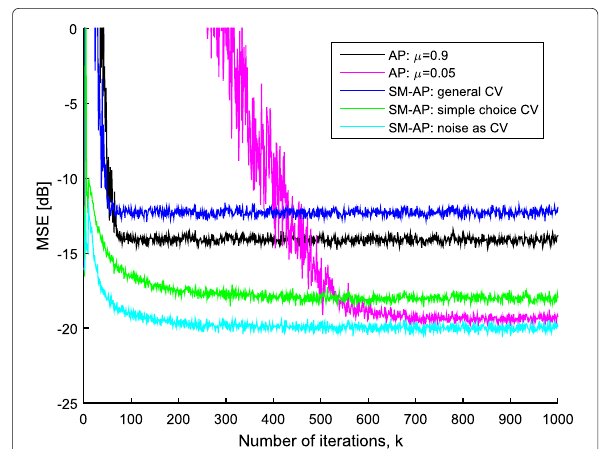
Fig. 8 Learning curves for the AP and SM-AP algorithm using different constraint